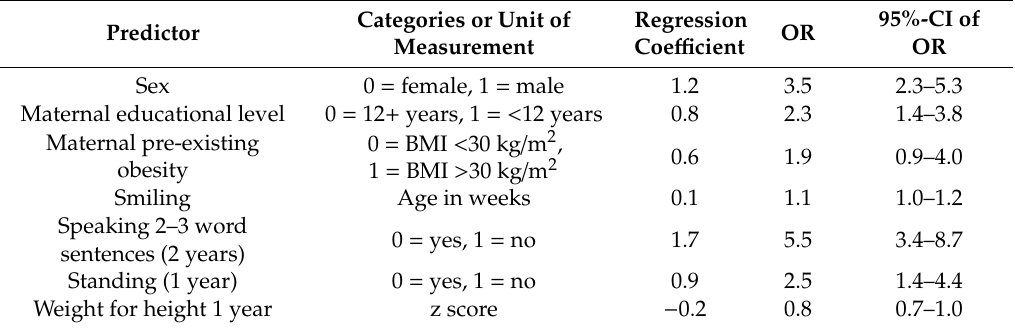
Table 2. Prediction model to identify children at risk of future developmental delay at age 4 according to the ASQ.